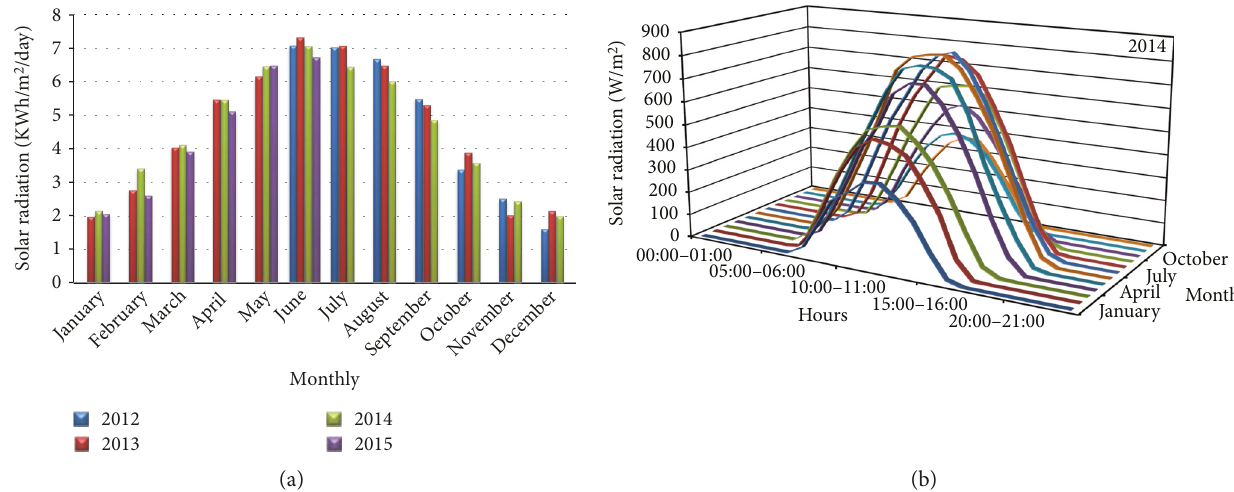
Figure 2: (a) Monthly averages of daily solar radiation throughout 2012 – 2015. (b) Hourly measured monthly average daily global radiation for 2014.